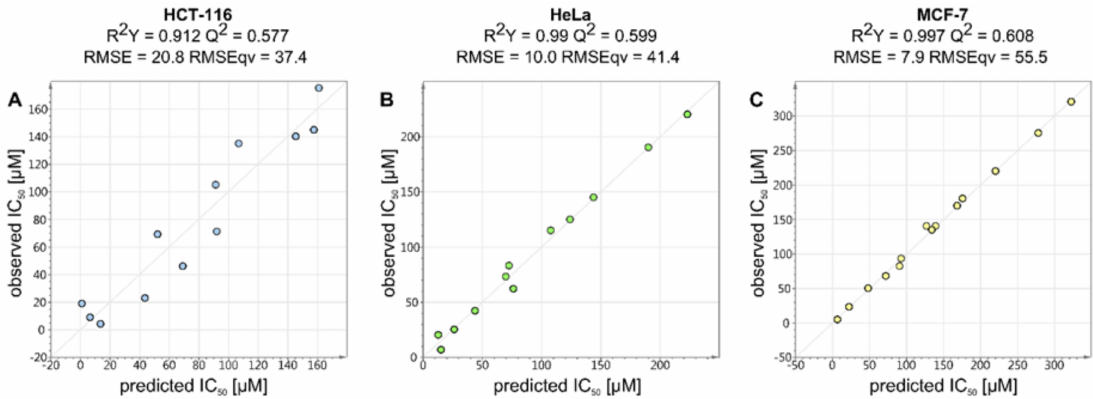
Figure 6. Observed versus predicted values for OPLS-based QSAR models for activity against ( A ) HCT-116; ( B ) HeLa; and ( C ) MCF-7 cell line. R 2 Y—coefficient of determination, Q 2 —cross-validated coefficient of determination, RMSE—root mean squared error, RMSEqv—root mean squared error for cross-validation